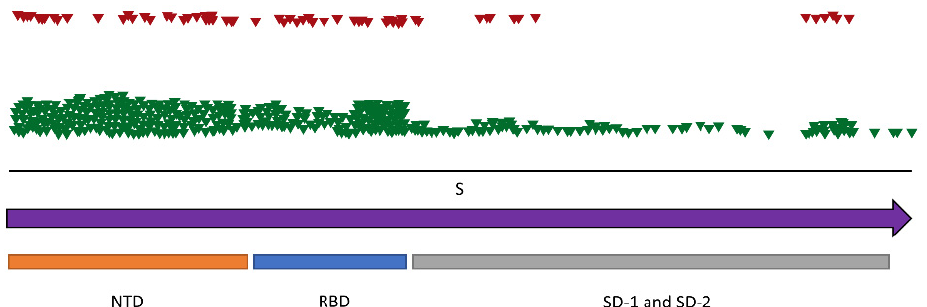
Figure 5. Overview of SNVs distributed over the spike protein locus (arrow) of MERS-related-CoV from the AG colony based on RT-PCR and Sanger sequencing. The domains (N-terminal domain of the S1 subunit ( NTD ); receptor-binding domain of the S1 subunit ( RBD ); subdomains of S1 and S2 subunits ( SD-1 and SD-2 )) were predicted by ClustalW alignment to the homologous regions of available MERS-related CoVs. Each triangle indicates an SNV; green, synonymous; red, non-synon- ymous.